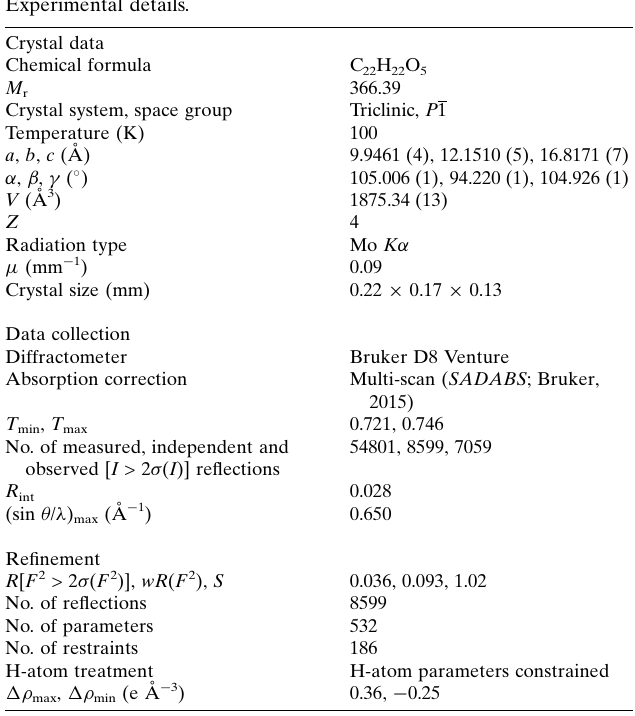
Table 2 Experimental details.